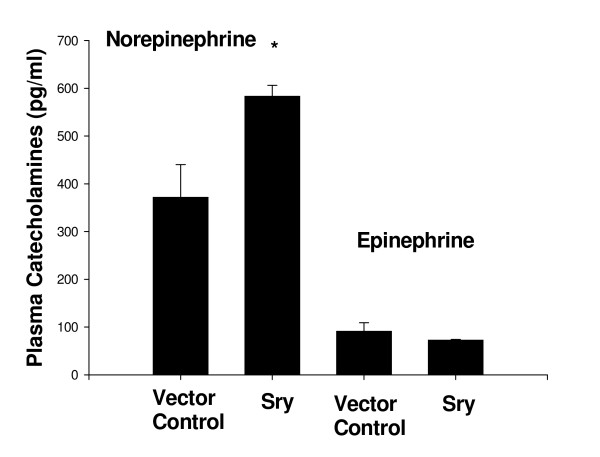
Plasma catecholamines 3 weeks after plasmid delivery (means +/-s.e.m., * = p < .05).